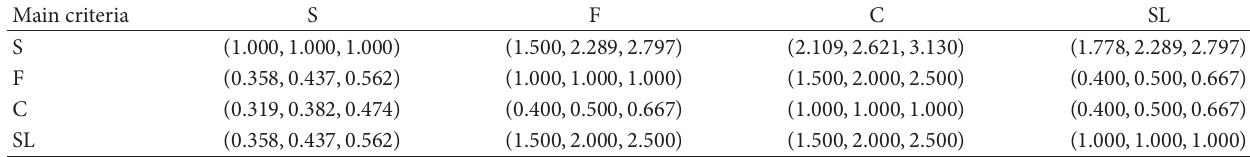
Table 4: Evaluation results of the criteria with respect to the